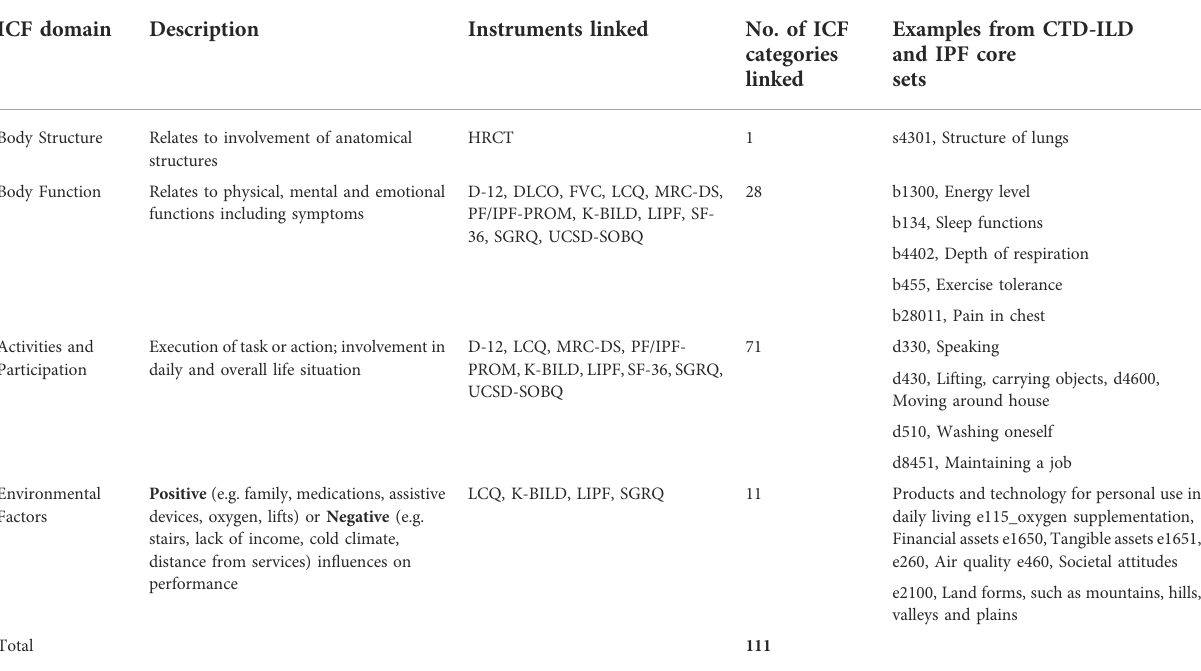
TABLE 2 Distribution of ICF categories and instrument occurrence per domain with example linkages. ( Courtesy of LA Saketkoo, with permission, rights reserved ) ICF